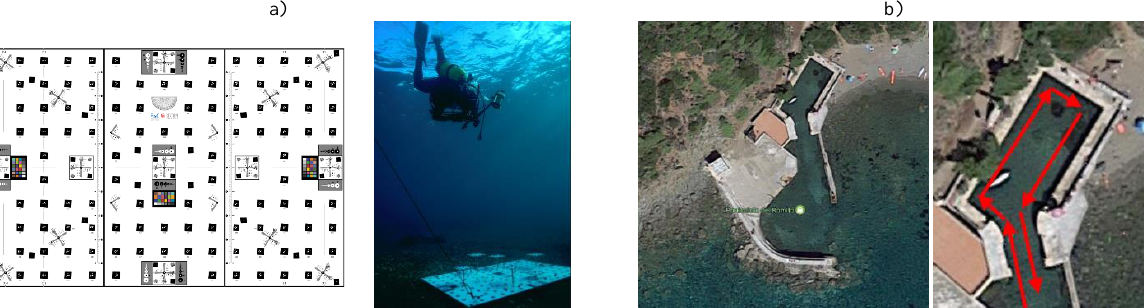
Figure 3. The modular test object used to study the effect of different weighting of the image observations together with a picture of a diver during the image acquisition stage (a). The semi-submerged industrial structure located in the Bay of Rogiolo near Livorno, Italy (Menna et al., 2018) with superimposed in red the circular loop strip along which underwater photographs were acquired (b).